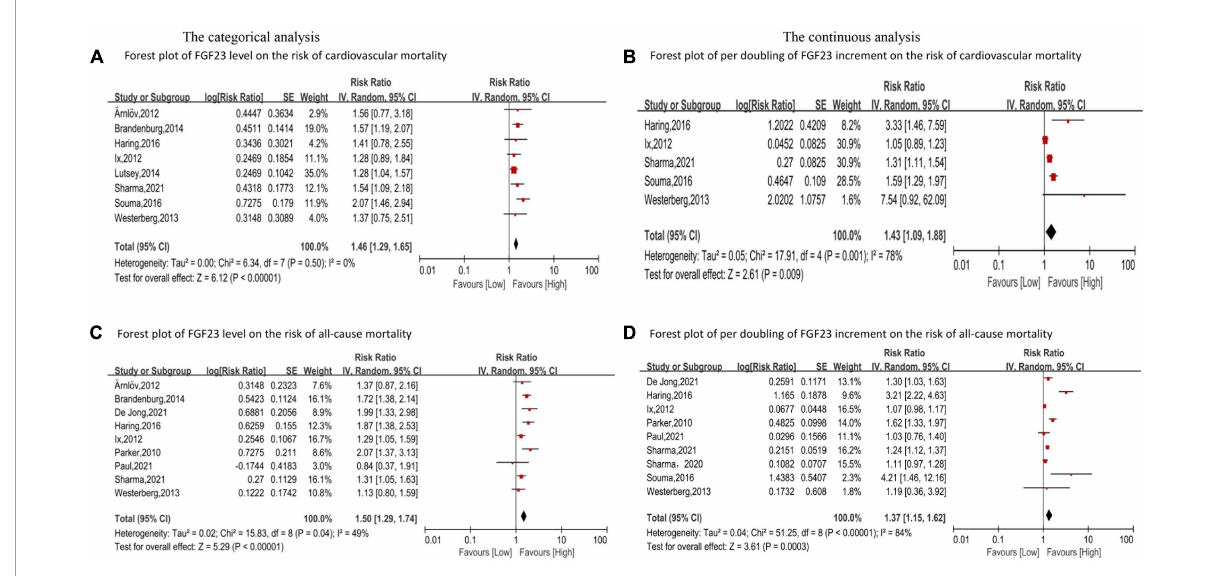
FIGURE4 Forest plot for the association between FGF23 levels and the risk of cardiovascular mortality (A) and all-cause mortality (C) in the general population, analyzed as category variable, highest vs. lowest; the association between per doubling of FGF23 increment and the risk of cardiovascular mortality (B) , and all-cause mortality (D) in the general population, analyzed as a continuous